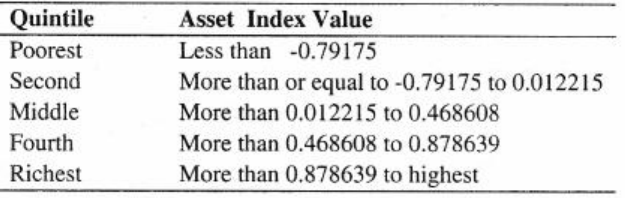
Table 2. Allocation pattern ofstandardized asset